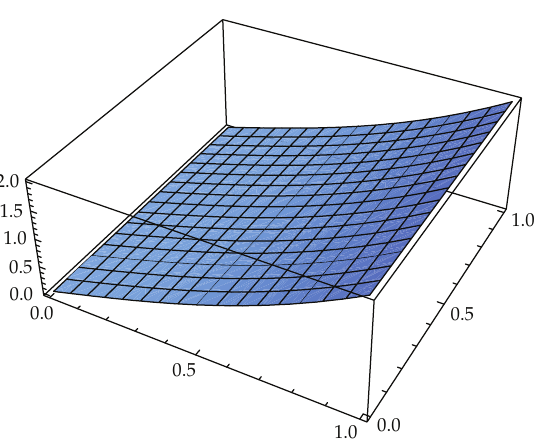
Figure 3: r -component u r (cid:3) r,θ,z (cid:4) (cid:5) (cid:3) 1 /r (cid:4)(cid:3) ∂ψ/∂z (cid:4) of the velocity profile given by OHAM, when R (cid:5) 1, γ (cid:5) 1.